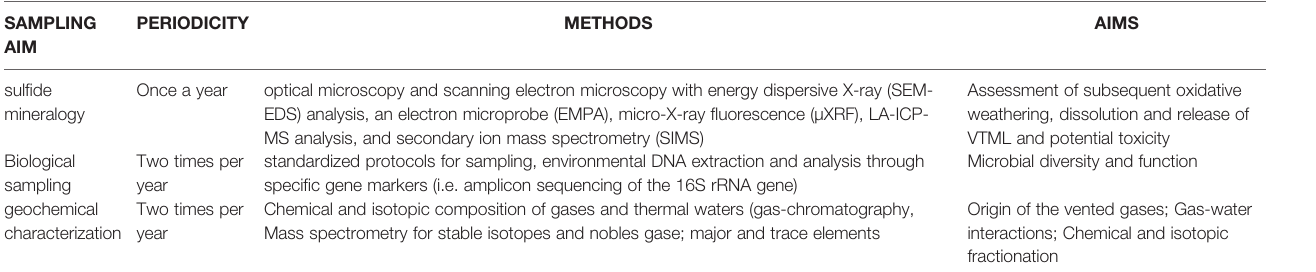
TABLE 2 | Shore-based activities performed by periodical